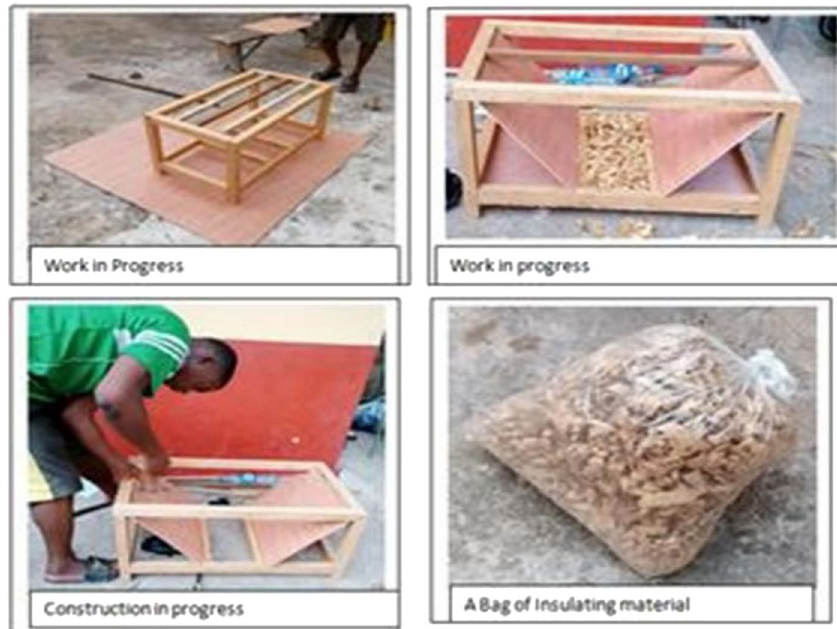
Fig. 14 Some of the photo- graphs taken by the researcher during the construction of the improved